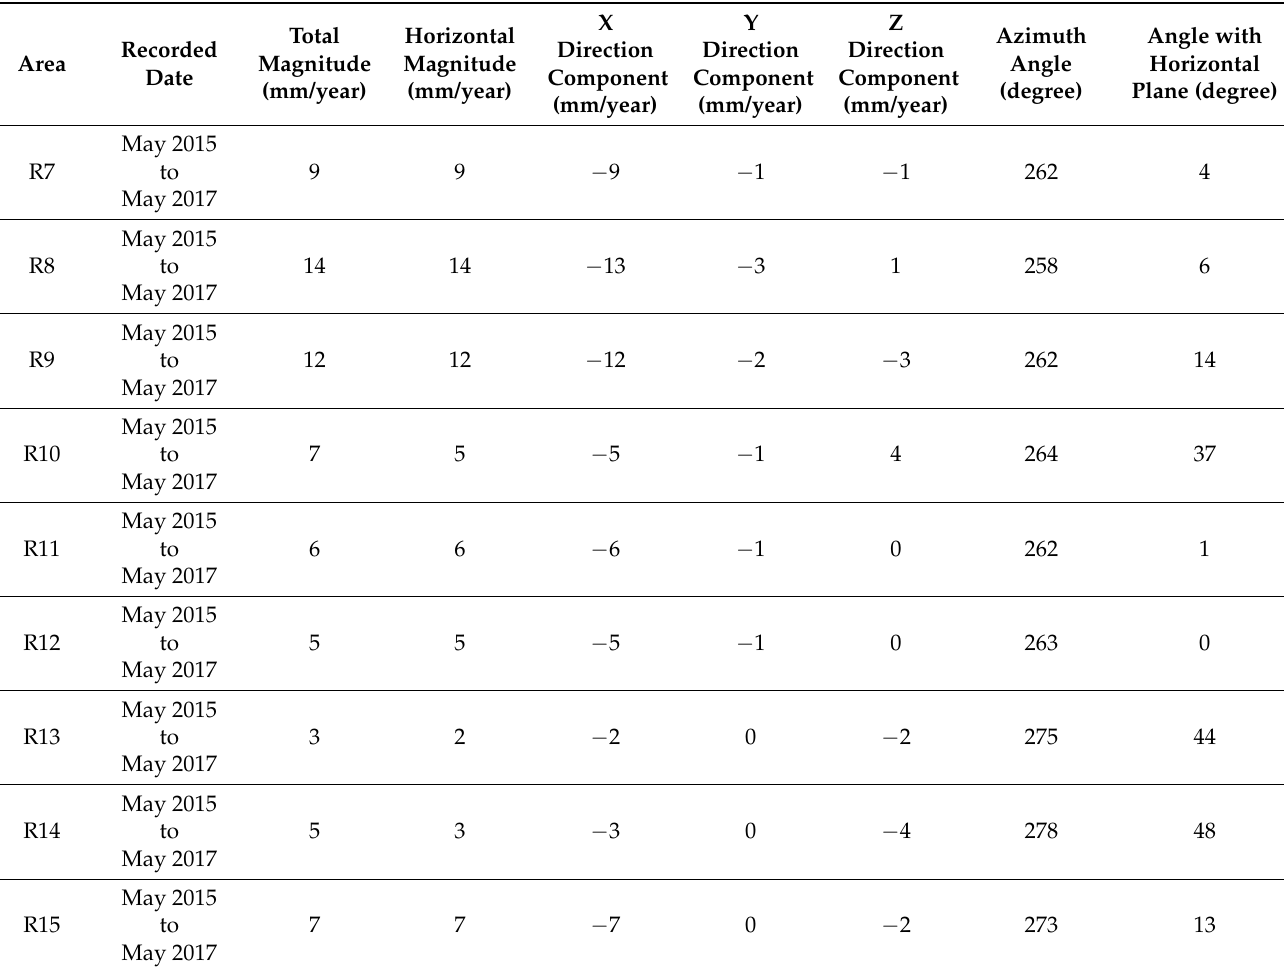
The cumulative 2-year LOS displacements at the Redhill landslide are shown in Figure 24. The toe of the Redhill landslide appears to be the most active area of the landslide. The 2-year time series of cumulative LOS displacements are shown in Figure 25. The toe of this landslide is the most active of all landslides in this paper. The cumulative LOS displacements exceed − 100 mm (ascending) and 60 mm (descending). Sectors at the backscarp (11–20) have cumulative LOS displacements between − 30 mm and +20 mm (considering both